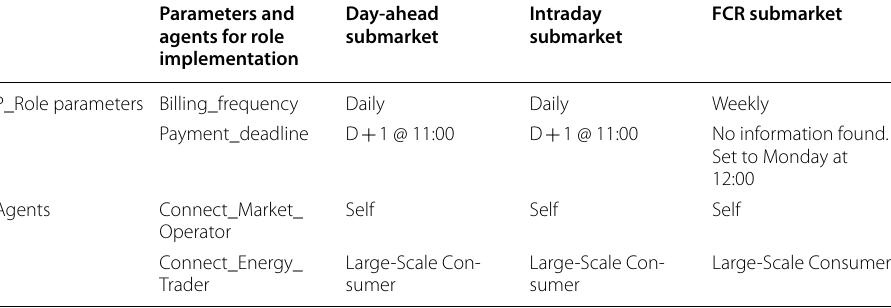
Table 5 Billing Agent role implementation for different submarkets (data from Energinet (2019); NordPool: NordPool Settlement